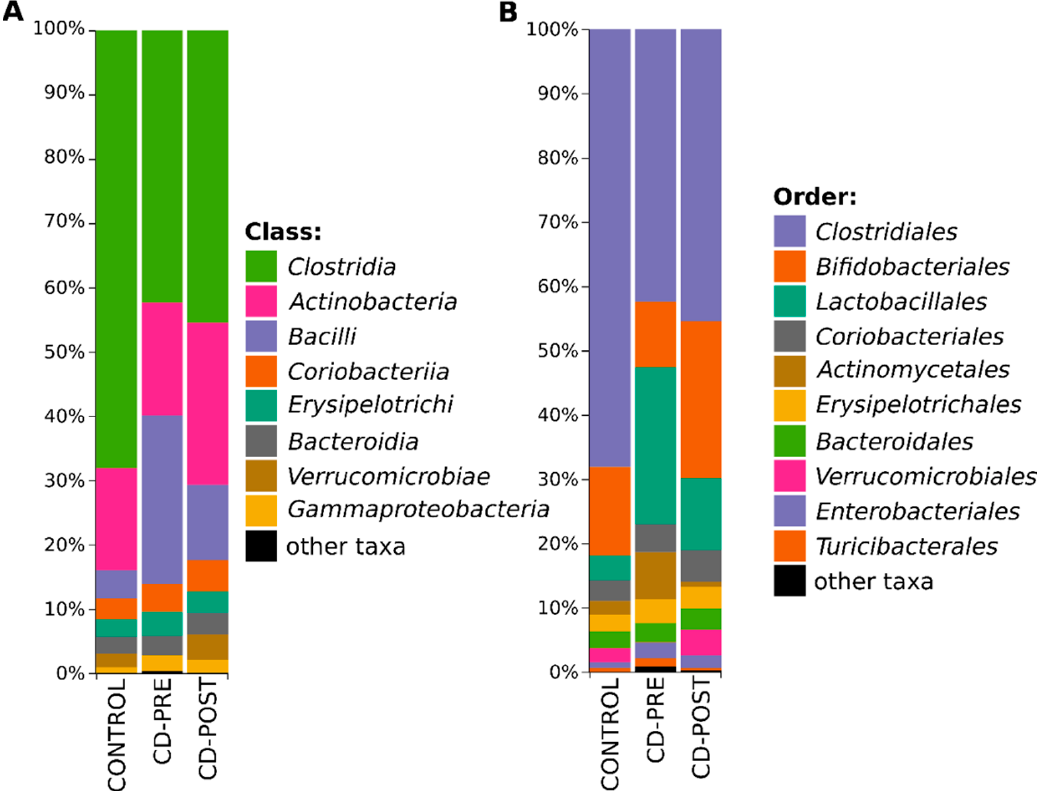
Figure 3. Relative abundance of most common bacterial classes ( A ) and orders ( B ) at each group. All taxa with abundance below 1% are represented as ‘other taxa’.